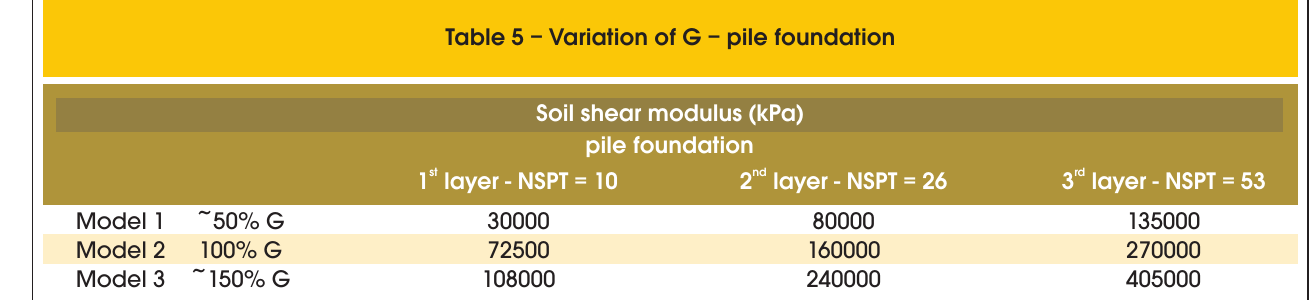
Table 5 – Variation of G – pile foundation